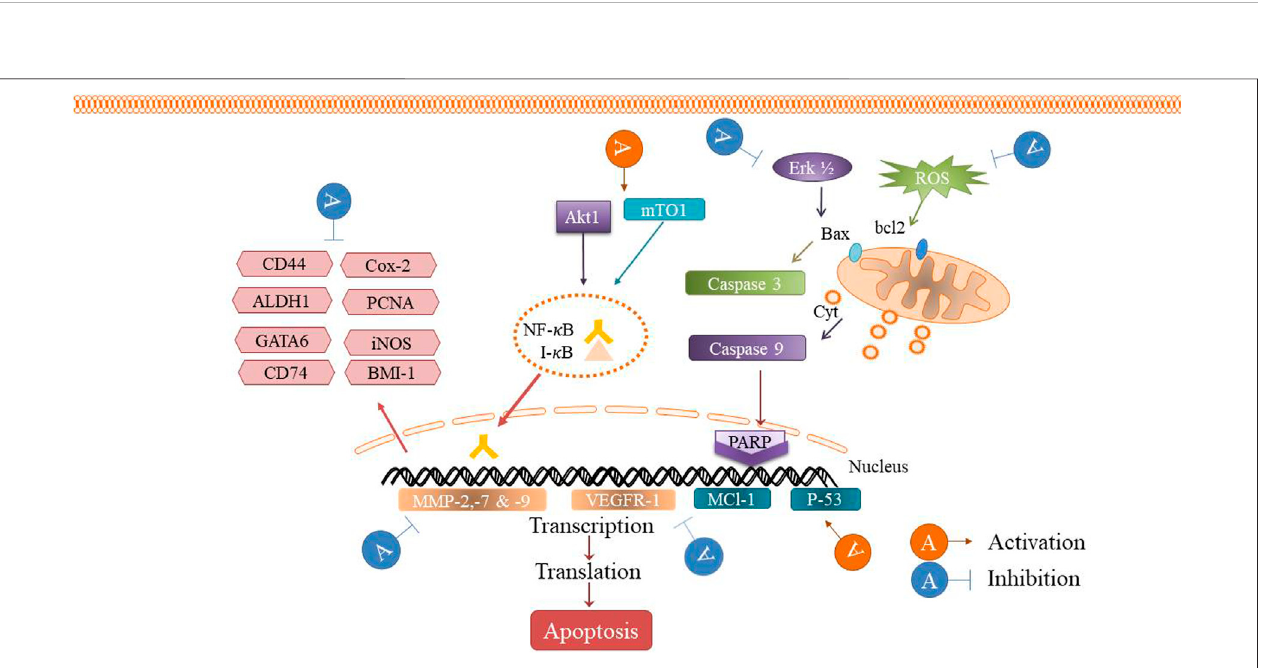
FIGURE 3 | The antitumor mechanism of